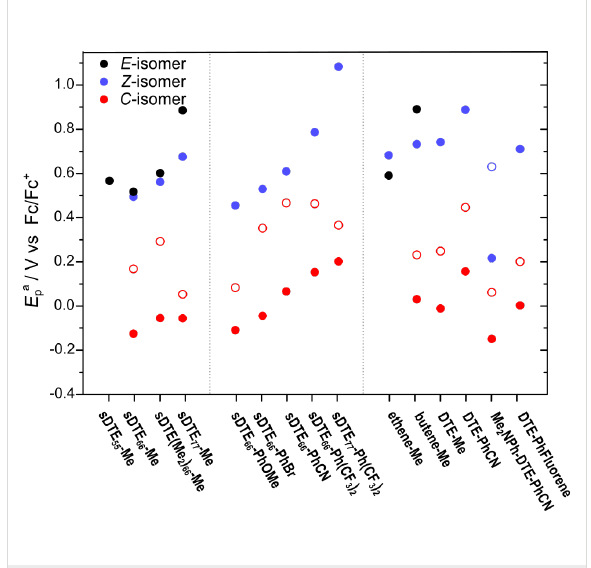
Figure 3: Anodic peak potentials ( E pa ) of sDTEs and reference com- pounds in MeCN. Solid circles refer to the first oxidation potential, hollow circles to the second oxidation potential (if available). For detailed data, see Table S1, for all respective cyclovoltammograms, see Figure S10 to Figure S27 in Supporting Information File